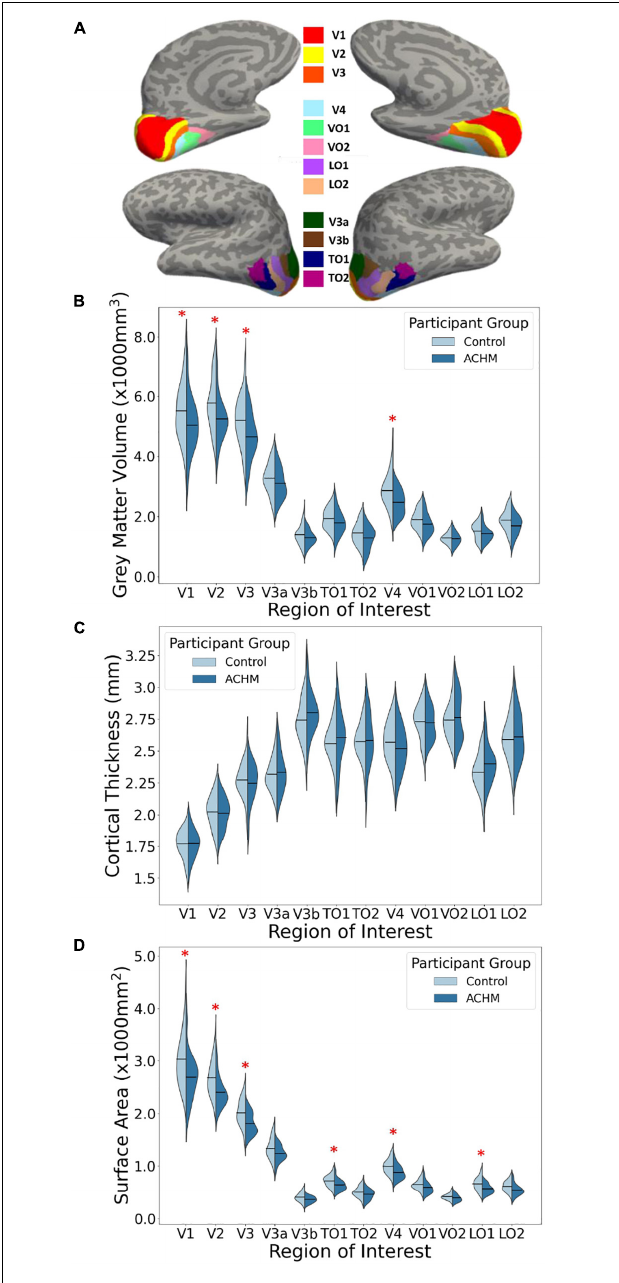
FIGURE 1 | Regions of interest and mean grey matter volume, cortical thickness and surface area for ACHM and controls. (A) An inflated surface of one control participant showing the cortical surface of the atlas-defined brain areas used in analysis (Benson et al., 2014; Benson and Winawer, 2018; https://osf.io/knb5g/). (B) A violin plot showing the distribution of mean grey matter volume averaged across the two hemispheres of controls and ACHM for each ROI. Horizontal lines within the violins indicate means for each group. Red stars indicate significant differences between groups in post hoc comparisons ( p < 0.05). (C) A violin plot showing the distribution of mean cortical thickness averaged across the two hemispheres of controls and ACHM for each ROI. Details as in (B) . (D) A violin plot showing the distribution of mean cortical surface area averaged across the two hemispheres of controls and ACHM for each ROI. Details as in (B) . Red stars indicate significant differences between groups in post hoc comparisons ( p <